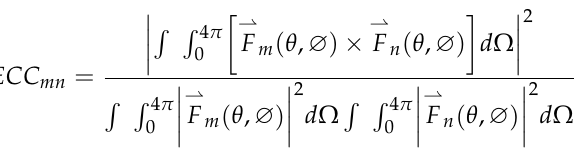
Figure 9. Simulated envelope correlation coefficient of the proposed transmitter subarray configu- ration.